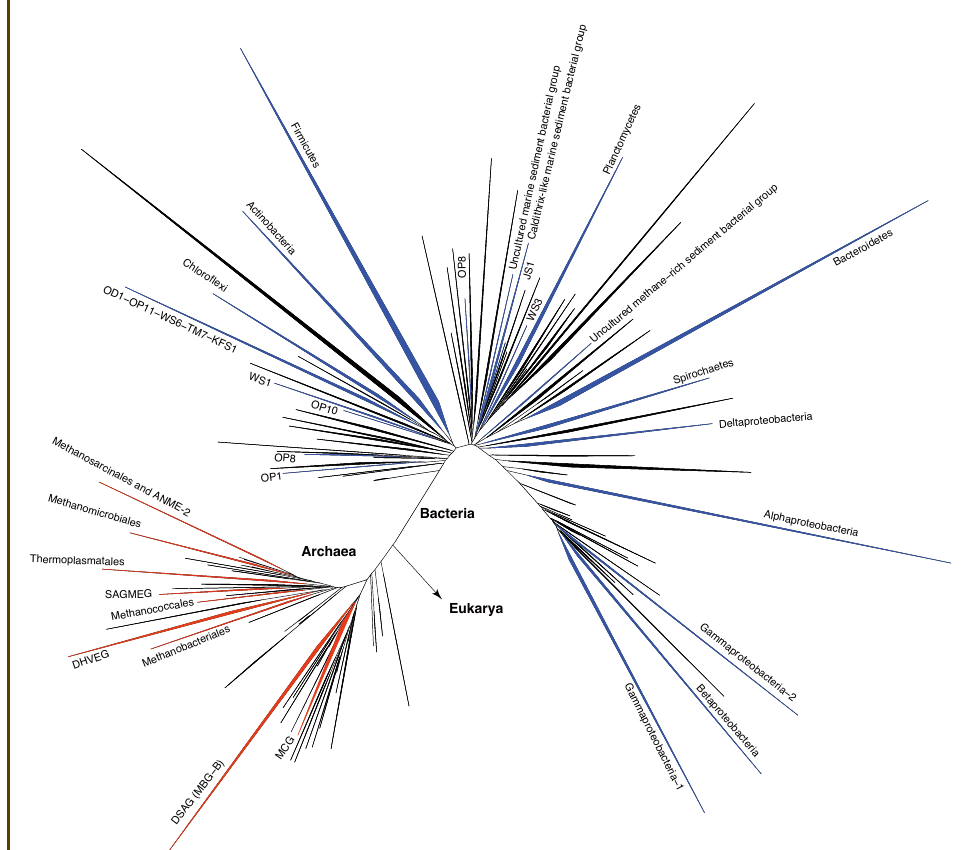
Figure 3. Phylogenetic tree of Archaea and Bacteria based on 16S rRNA gene sequences (from Inagaki, 2010). The red and blue branches represent archaeal and bacterial phyla, respectively, and include sequences frequently detected from the deep subseafloor